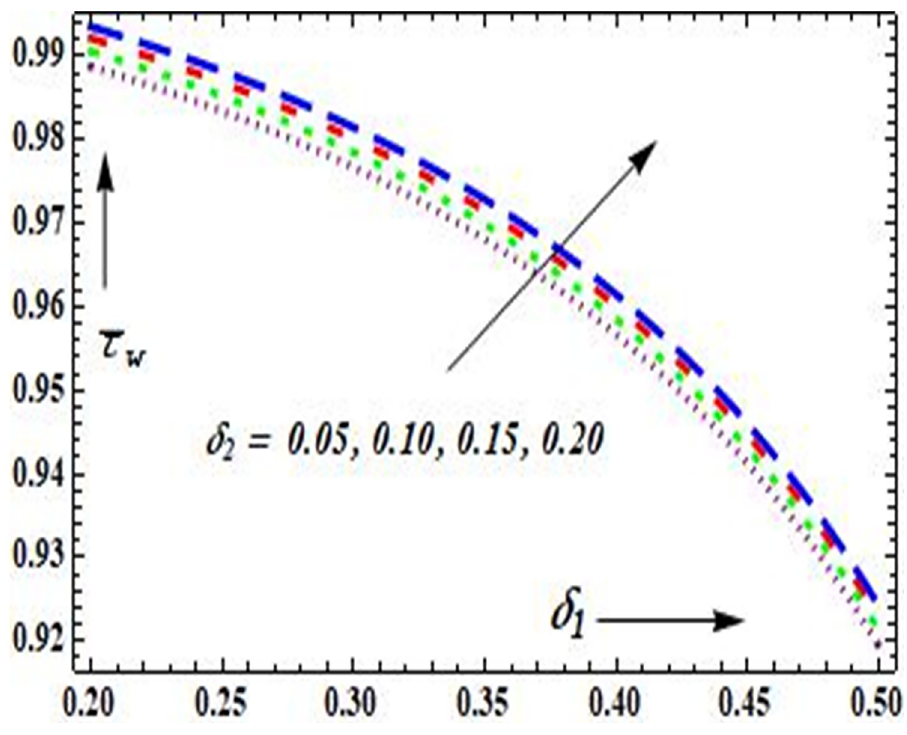
Fig 16. Plot of � τ